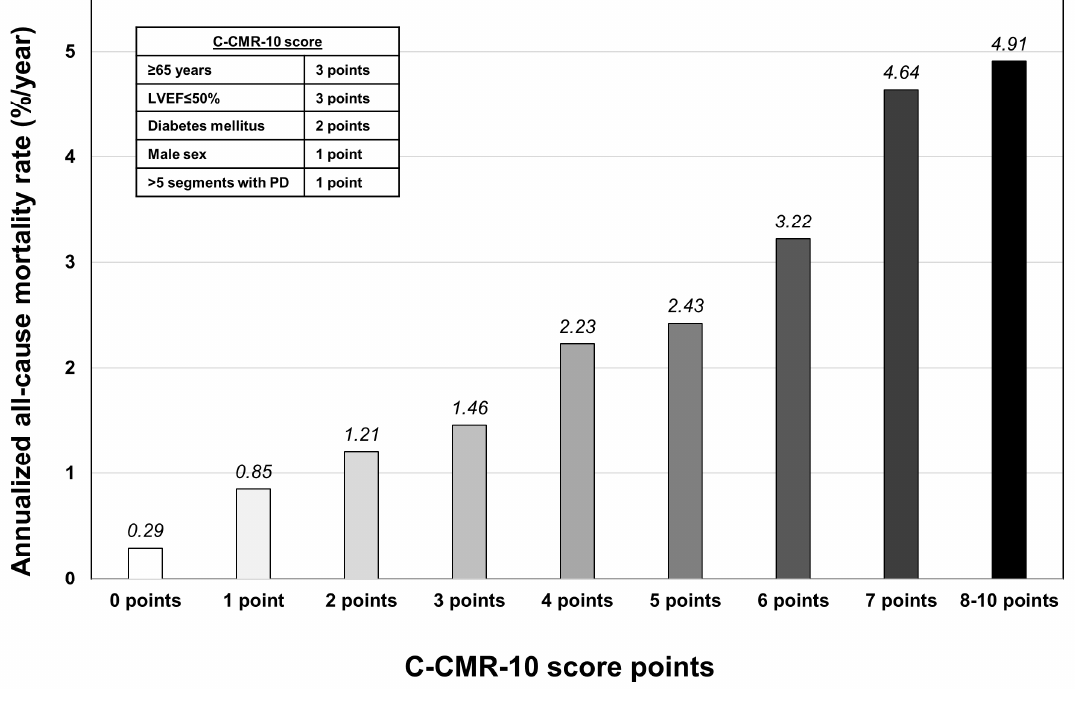
Figure 3. Annualized all-cause mortality risk stratification according to clinical-stressCMR (C-CMR-10) score points. Abbreviations: LVEF = Left ventricular ejection fraction. stressCMR = Vasodilator stress cardiac magnetic resonance. PD = Perfusion defects on stressCMR.